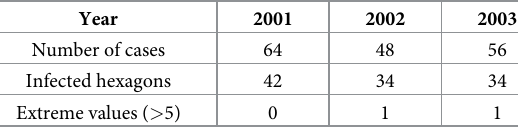
Bovine tuberculosis is a disease caused by a bacterium which can affect the cattle [47] and